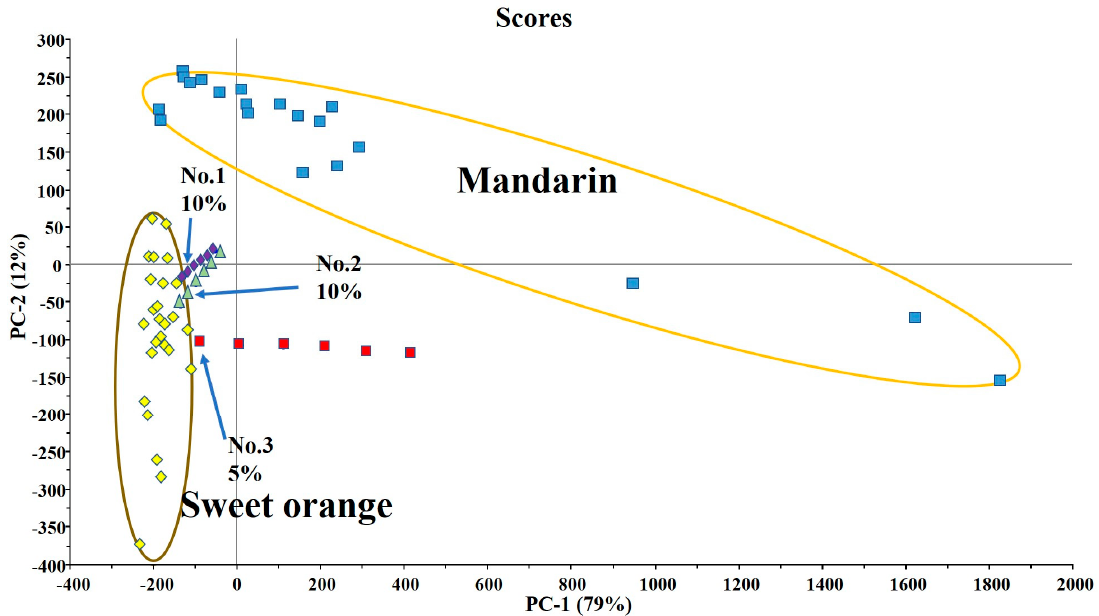
Figure 4. Discrimination of sweet orange juices mixed with di ff erent proportions of mandarin juices. No. 1 mixture series are made of Olinda Valencia orange and Xinshengxi No.3 Ponkan juices; No. 2 mixture series are made of Hamlin orange and 2003-4 Satsuma juices; and the No. 3 mixture series are made of Long-leaf orange and Nanfeng mandarin juices. The percentage is the volume fraction of mandarin juices that blended into orange juices. Each group of six points represents a di ff erent volume percentage ( v : v = 5:95, 10:90, 15:85, 20:80, 25:75, and 30:70).